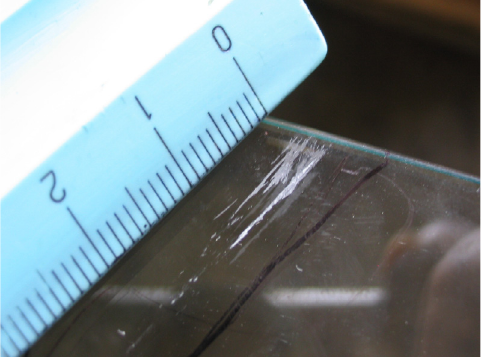
Figure 2: Some typical surface defects detected under the quality control of tempered glass plates in the production